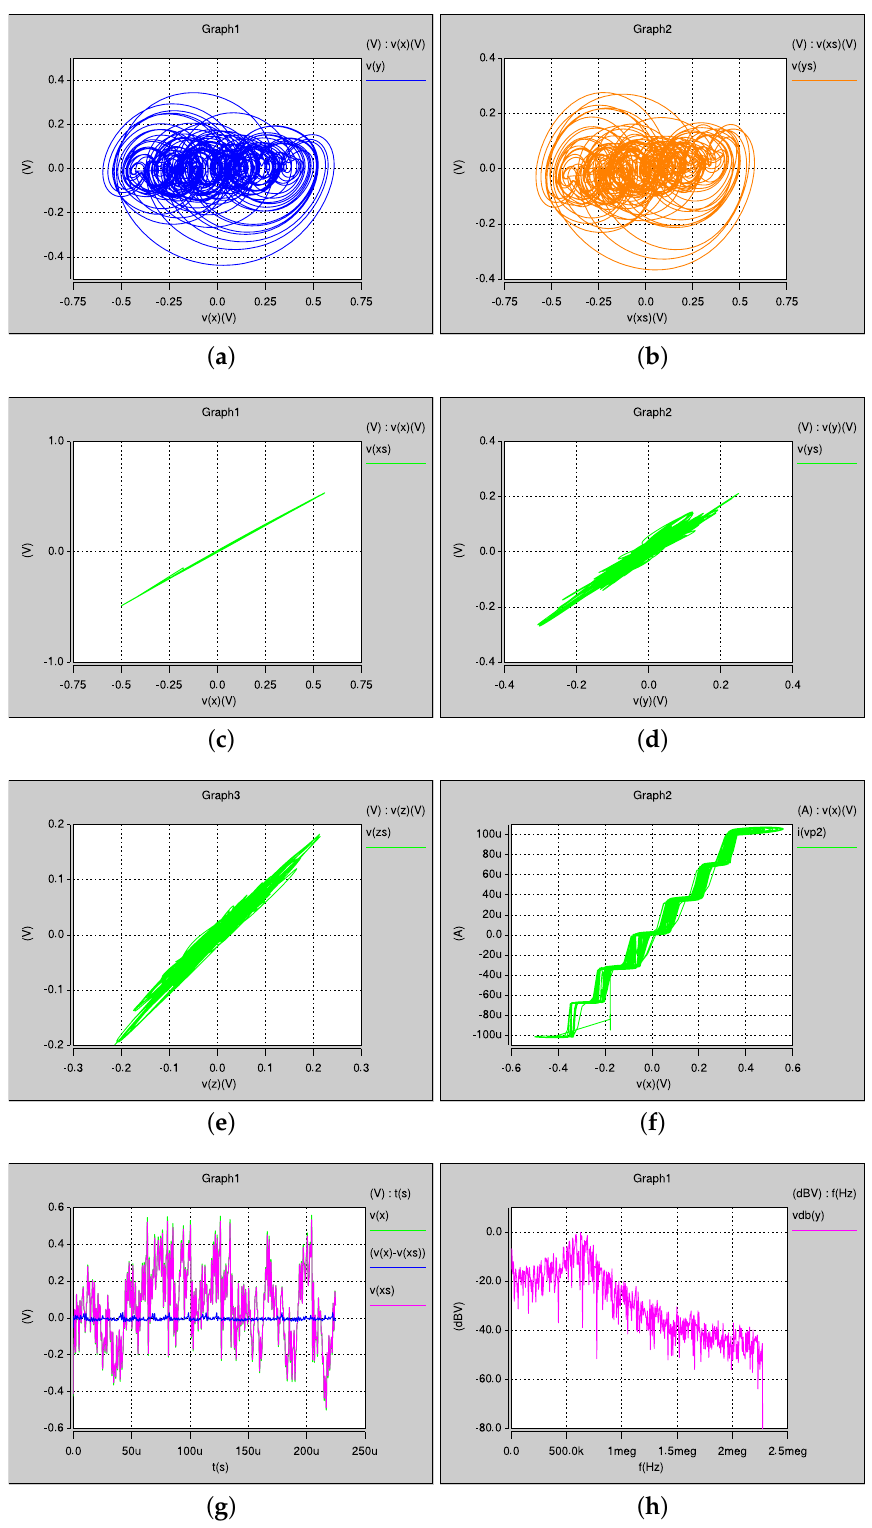
Figure 20. Post-layout simulation for the synchronization of two seven-scroll chaotic oscillators with optimized MLE: ( a ) master oscillator showing x 1 vs. x 2 ; ( b ) slave oscillator showing ξ 1 vs. ξ 2 ; ( c ) synchronization of x 1 vs. ξ 1 ; ( d ) synchronization of x 2 vs. ξ 2 ; ( e ) synchronization of x 3 vs. ξ 3 ; ( f ) SNLF f ( x 1 ) to generate seven-scroll; ( g ) synchronization error x 1 − ξ 1 ; and ( h ) FFT analysis of x 2 showing f = 626.67